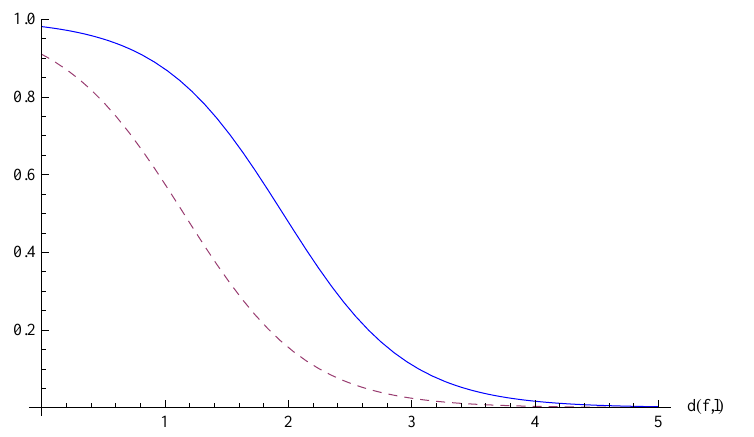
Figure 3: Two illustrative membership functions showing the effect of a difference in proximity on the relationship between distance from a category schema/prototype and the probability of labeling; see